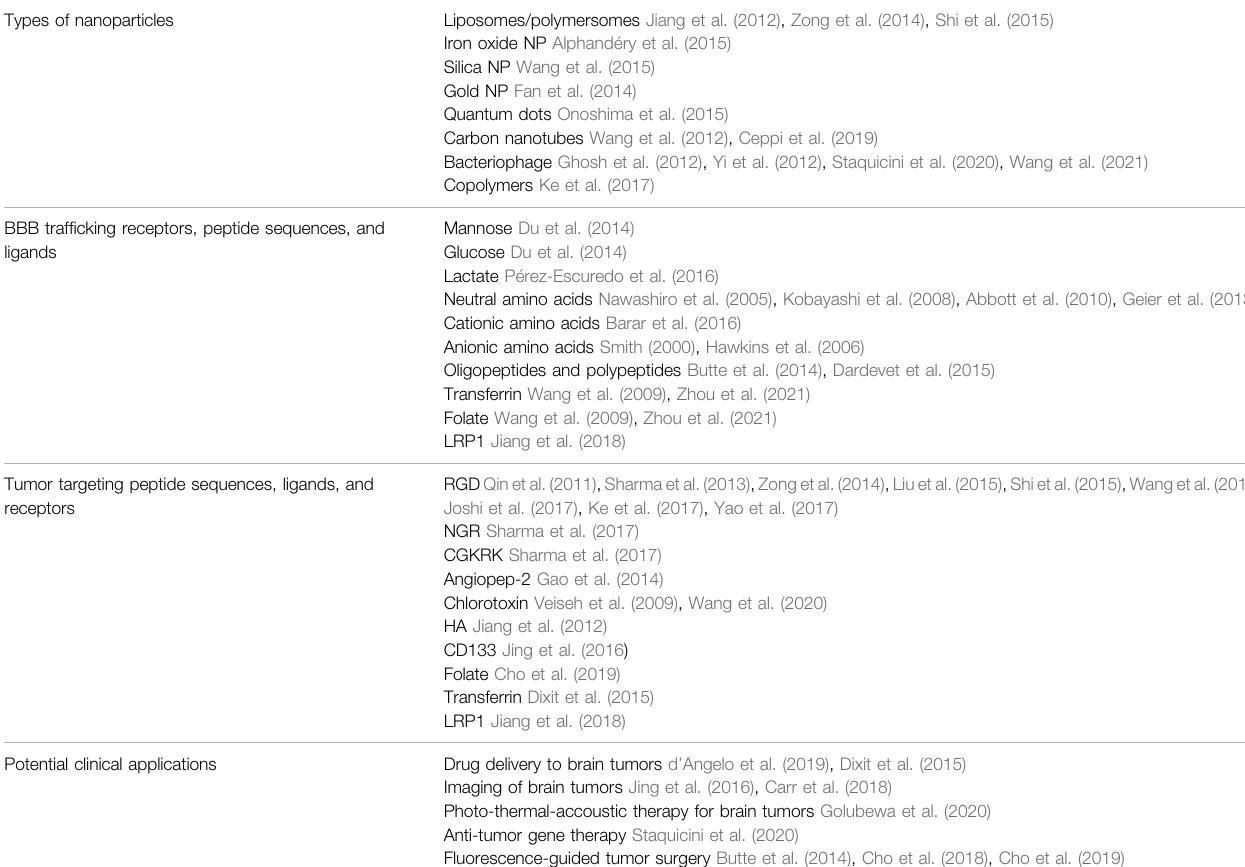
TABLE 1 | Summary of different physicochemical and functional properties of nanoparticles with their potential clinical applications in neurosurgical oncology. Types of